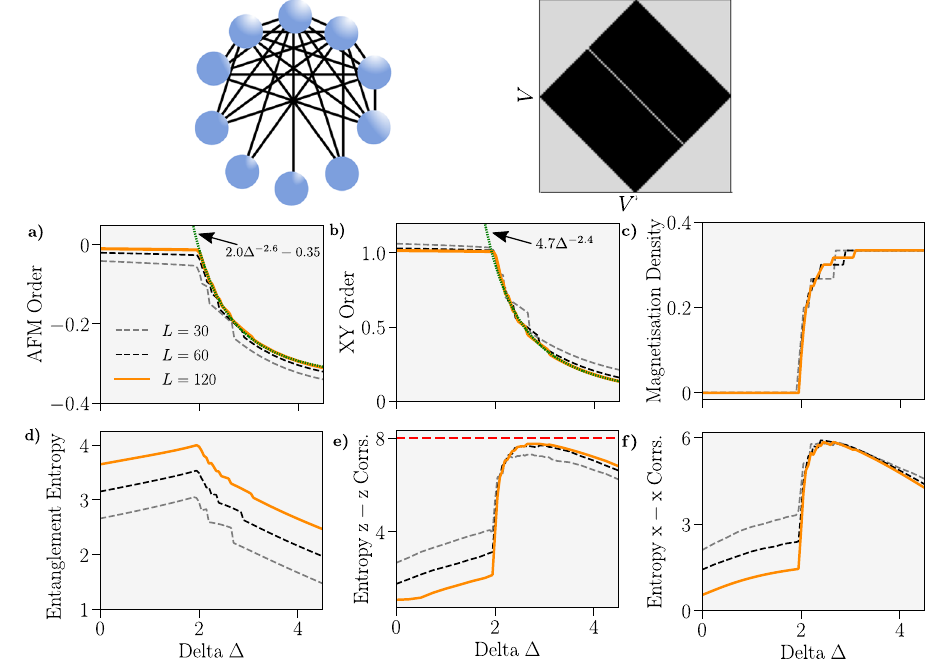
− x correlations (see the “ Methods ” section) versus Δ . We use n =256 bins to cal- culate theShannon Entropy.Power-lawcurveshave been fi ttedto C AFM and C XY for Δ >2and L =120andmarkedingreen.Adottedredlinehasbeenaddedtoplot e) to indicate the maximum possiblevalue for the Shannon Entropy with the number of bins